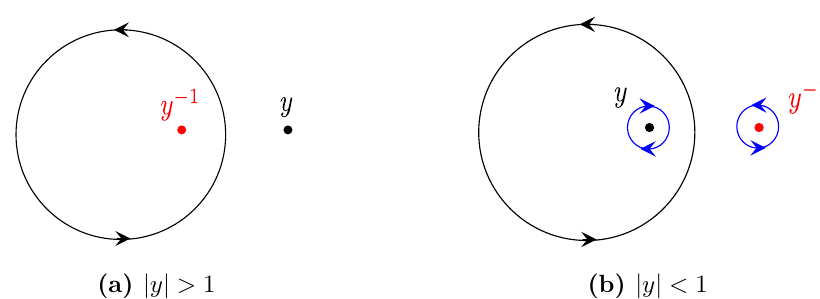
Figure 12. The integration contour for x for (a) | y | > 1, and (b) | y | < 1. When | y | > 1, the integration contour is along a unit circle. However, if we analytically continue this integral to | y | < 1, the poles in the integrand x = y ± 1 cross the contour and produce extra contributions (small circles around y ± 1 ). In the strong coupling limit, such extra contributions are